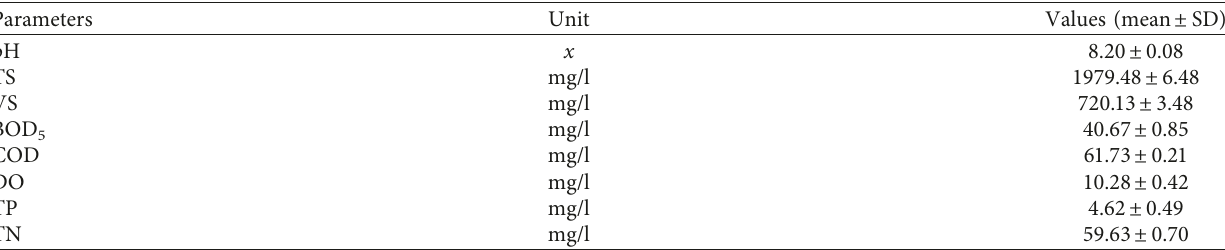
Table 2: Composition of raw